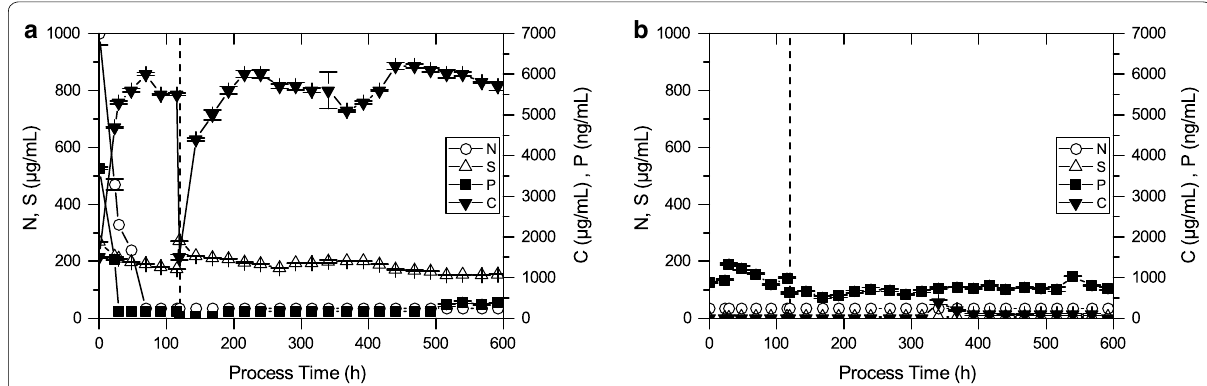
Fig. 5 Time course of residual macronutrient concentrations for nitrogen, phosphorus, sulfur, and carbon in photobioreactor cultivations of Syn- echocystis sp. PCC 6714 cultivated photoautotrophically and with nitrate as the nitrogen source is shown a in the culture supernatant b intracellular concentration of the macronutrients. *The vertical bar represents the start of the limitation phase. The values shown are the mean of three individual experiments, a single standard deviation is given as error